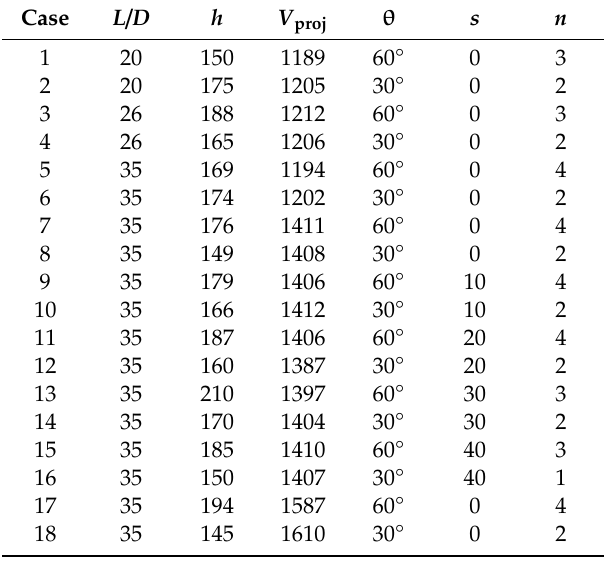
Table 2. Results of the dynamic impact